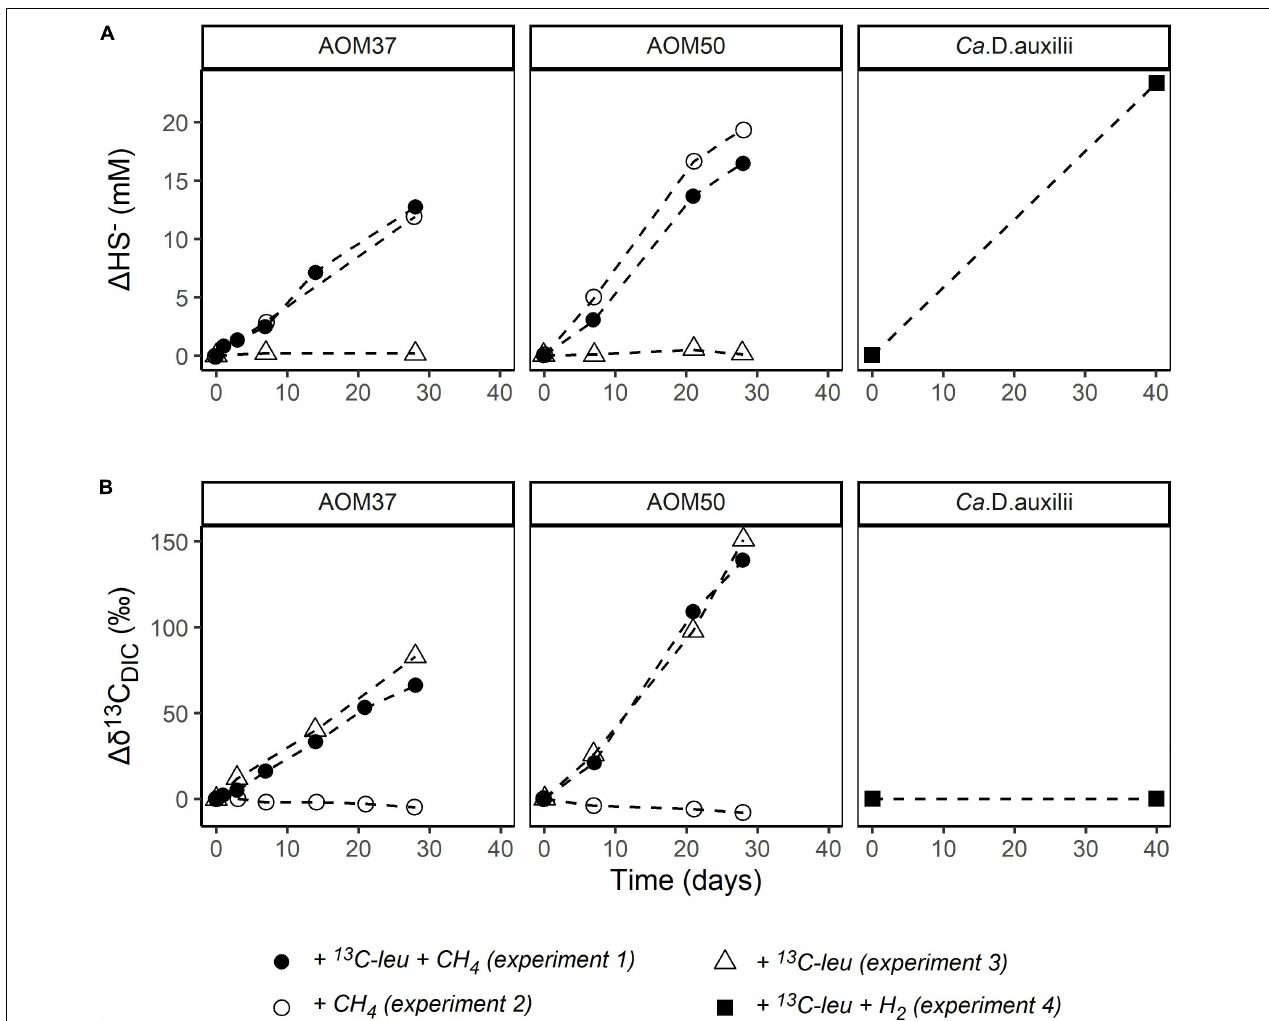
, B ) relative to T 0 in the incubation experiments with the AOM37 and AOM50 cultures over 28 days (cid:104)